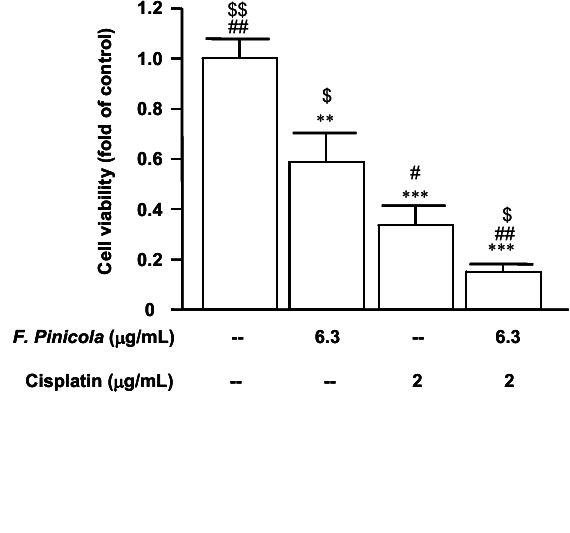
Figure 6. F. pinicola ethanol extract enhances the anti-tumor activity of cisplatin. Sarcoma S-180 cells were treated with F. pinicola ethanol extract, cisplatin or F. pinicola ethanol extract plus cisplatin at indicated doses for 24 h. Cells were then incubated with 0.2 mg/mL MTT in culture medium for 4 h. MTT reagent was discarded and DMSO was added. The absorbance was measured at the wavelength of 570 nm. The data was obtained from three independent experiments with four replicates for each experiment. ** p < 0.01 and *** p < 0.001 compared with the control group. # p < 0.01 and ## p < 0.001 compared with F. pinicola ethanol extract-treated alone group. $ p < 0.05 and $$ p < 0.01 compared with cispltin-treated alone